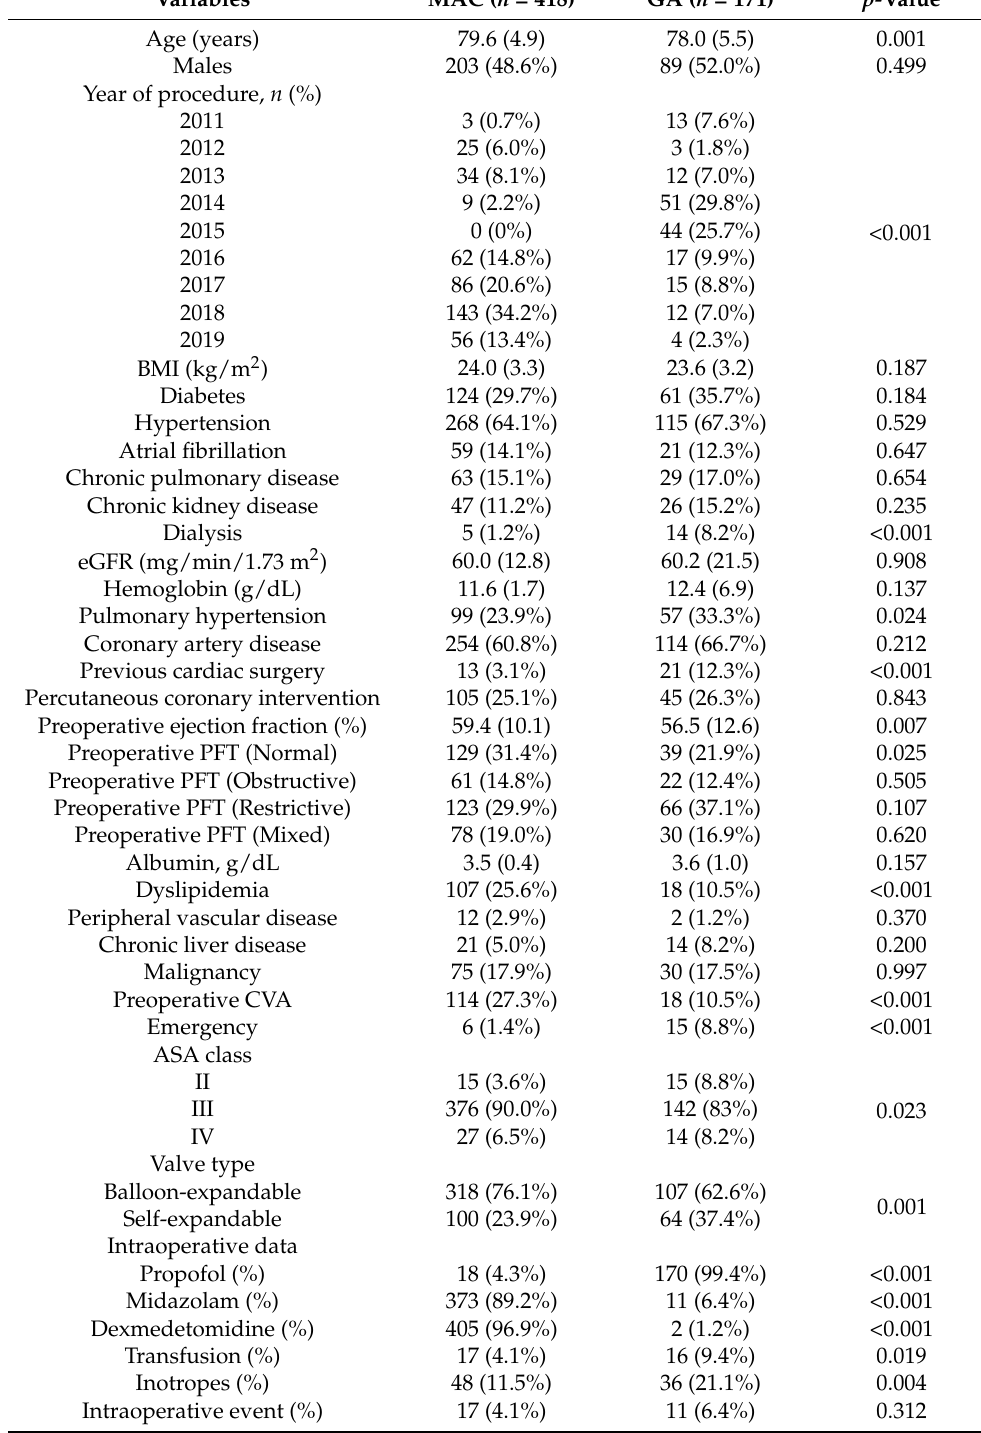
Table 1. Baseline demographic and clinical characteristics of patients who underwent transcatheter aortic valve replacement under MAC or GA. Values are presented as the mean (standard deviation) or number